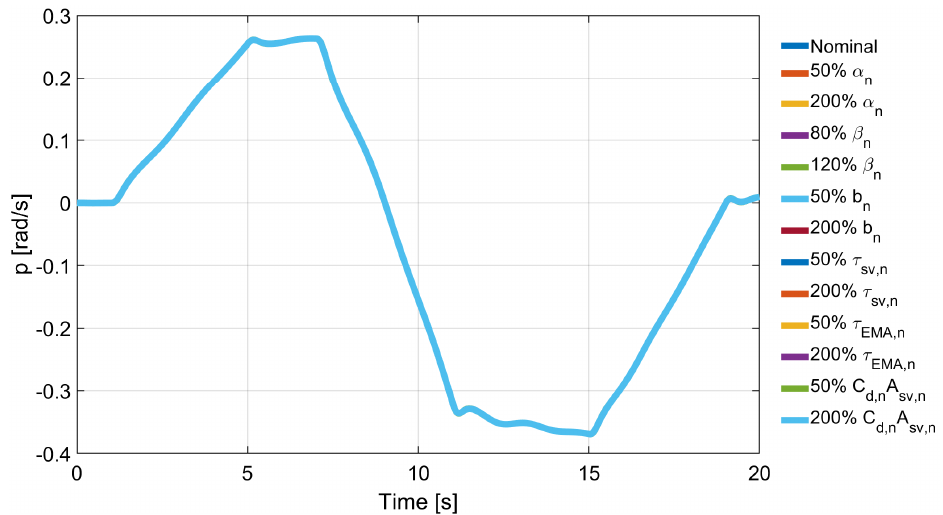
Figure 23. Simulation #3: Roll Rate from the Aircraft